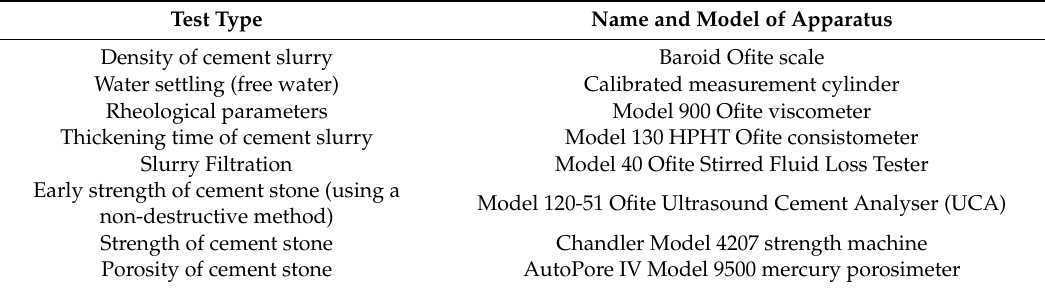
Table 3. Research apparatus used during laboratory